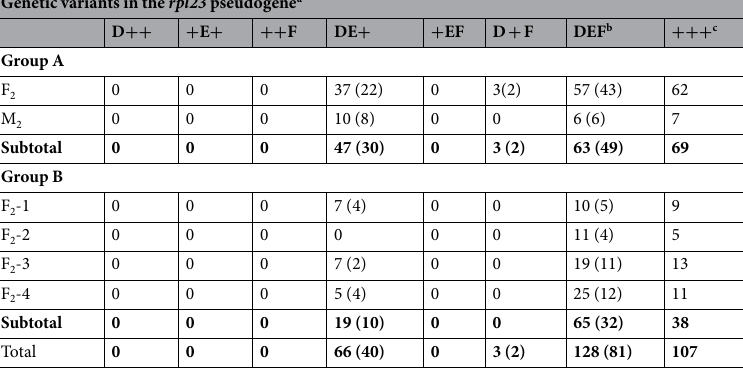
Table 2. Number of seedlings carrying different rpl23 pseudogene variants in the two groups of cpm families. a The number of homoplastomic seedlings is shown in brackets. b D, E and F represent the polymorphic positions in the cpm rpl23 pseudogene (blocks D, E and F). c + represents the wild type